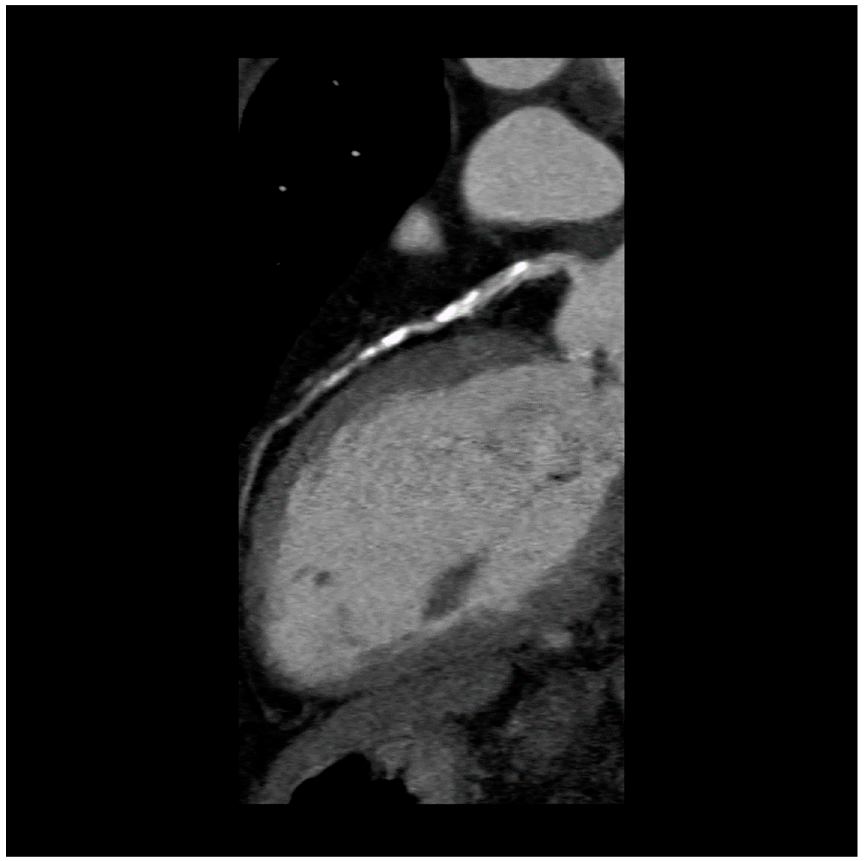
Figure 2. Coronary computed tomography angiography. 59-year-old woman with type-2 diabetes, symptomatic for stable angina, showing extensive calcified plaques of the LAD coronary artery.